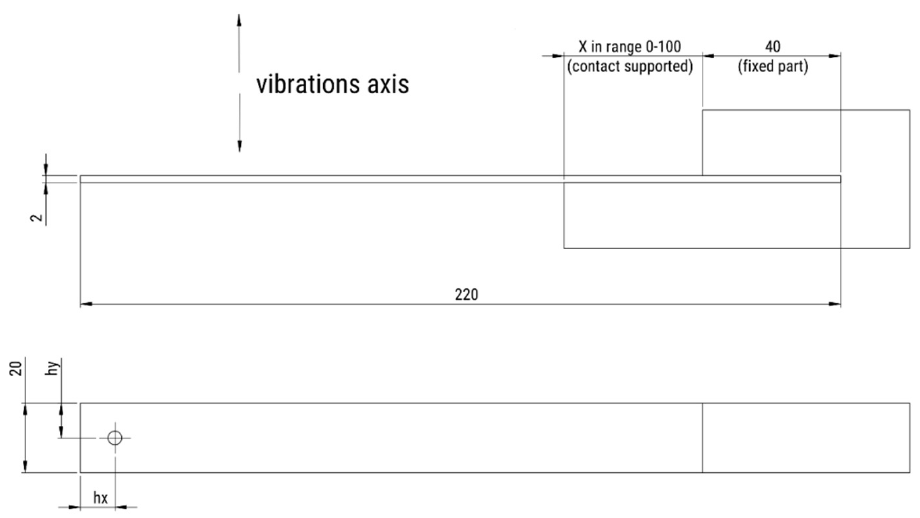
Figure 3. Scheme of the specimen mounted in the grip. Table 2. Measured dimensions of manufactured test specimens.